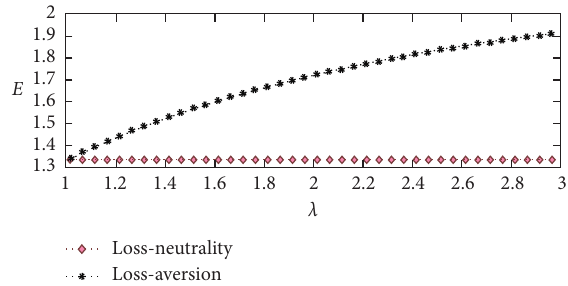
Figure 10: Effect of λ on environment ( N � 5 and R � 1).